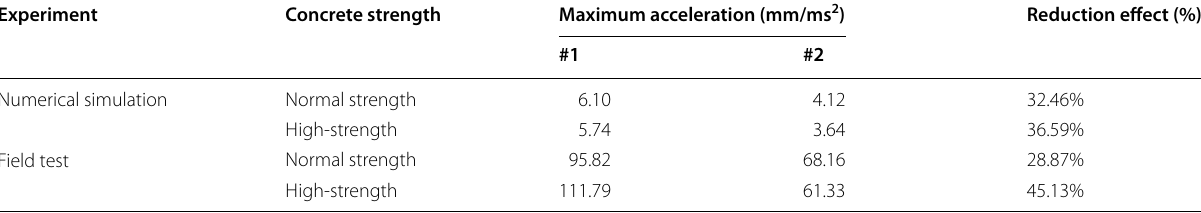
#1: Outside surface of concrete on the side without blast-proof panel. #2: Outside surface of concrete on the side with blast-proof panel.